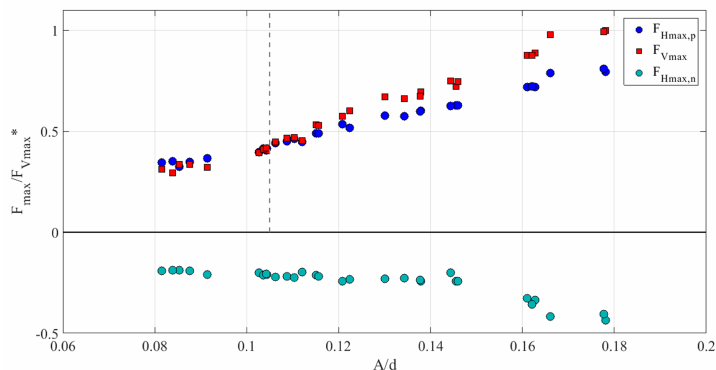
Figure 6. Maximum positive and negative peaks of experimental horizontal forces ( F Hmax , p and F Hmax , n , respectively), and maximum positive peaks of experimental vertical forces ( F Vmax ), vs. A / d